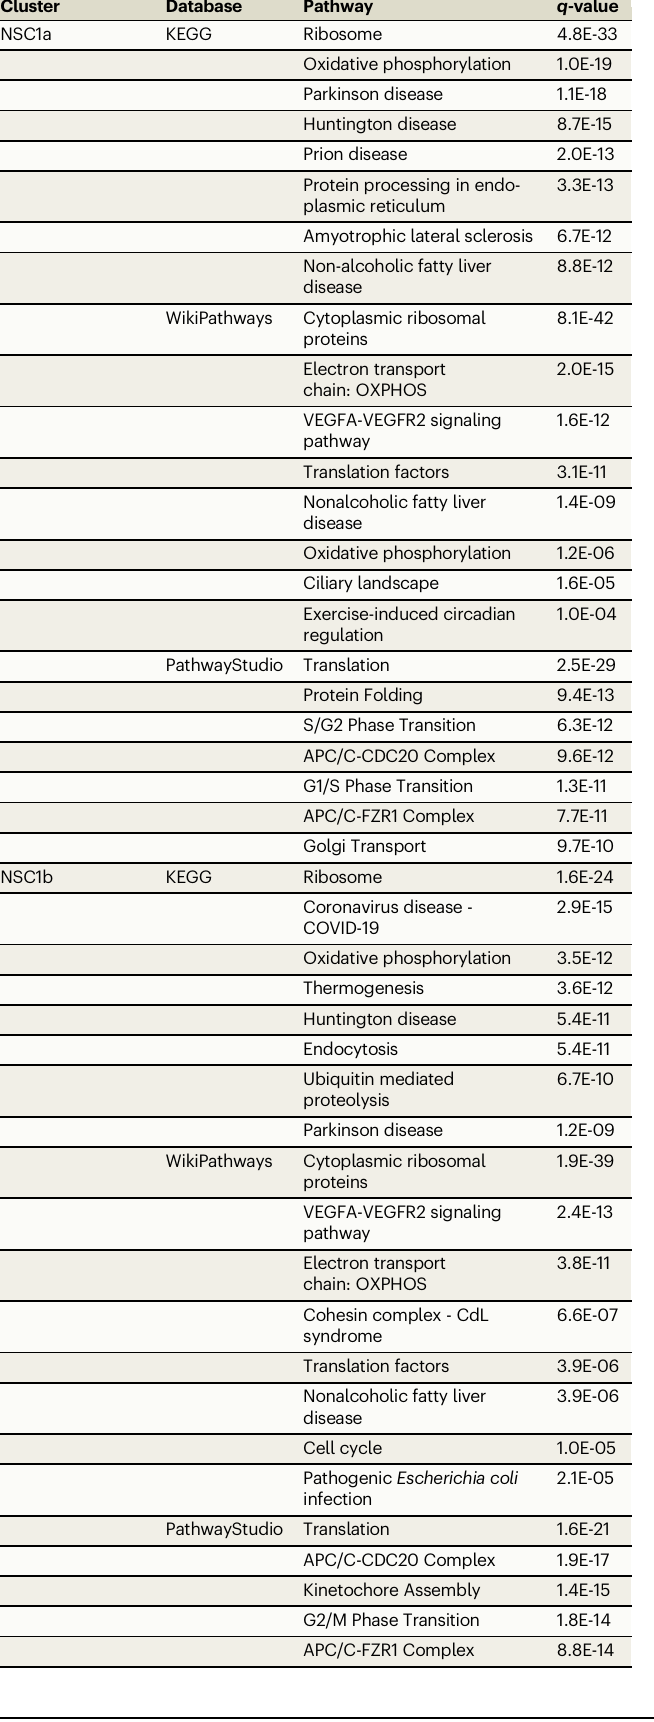
Table 1 (continued) | Top 8 pathways signi fi